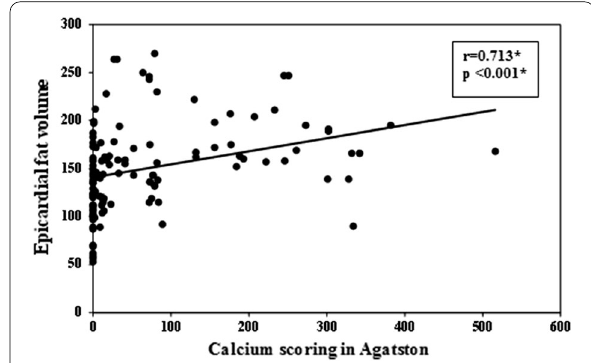
Fig. 6 Correlation between epicardial fat volume and Calcium scoring in Agatston ( n 120) =